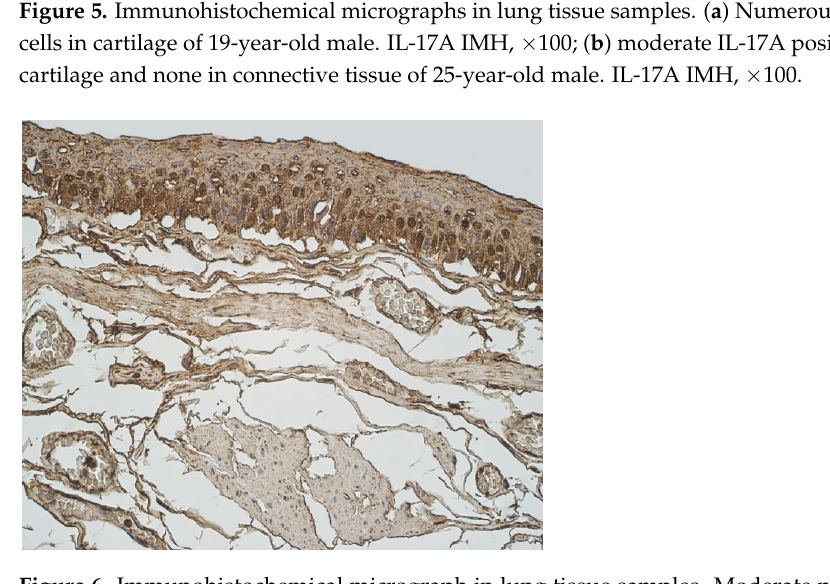
Figure 6. Immunohistochemical micrograph in lung tissue samples. Moderate number of IL-17A positive epitheliocytes and occasional number of positive connective tissue cells in 45-year-old male. IL-17A IMH, ×400. Table 3. Relative number of cathelicidine and IL-17A-positive structures in the healthy lung structures: cartilage, connec- tive tissue, glands, bronchial epithelium, alveolar macrophages and alveolar epithelium. Nr